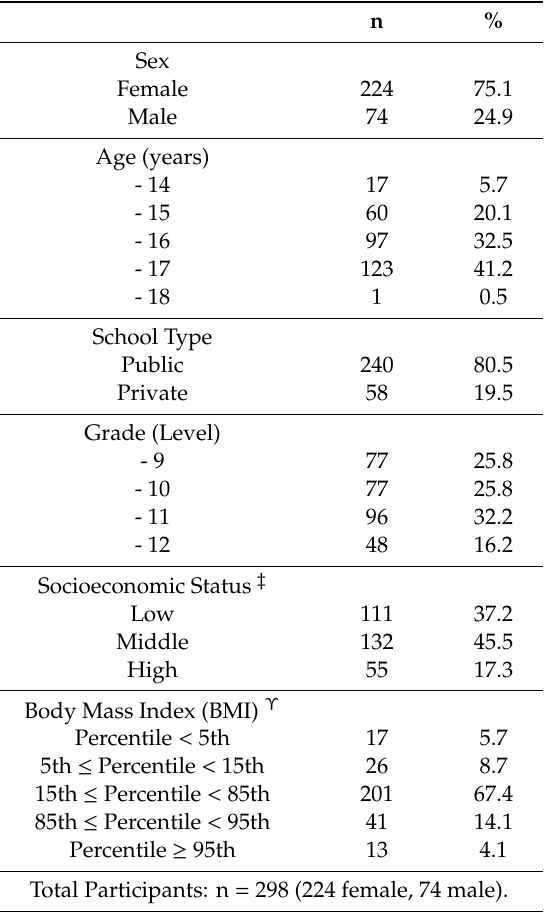
Table 1. Student Distribution by: sex, age, school type / class and socioeconomic status. n % Sex